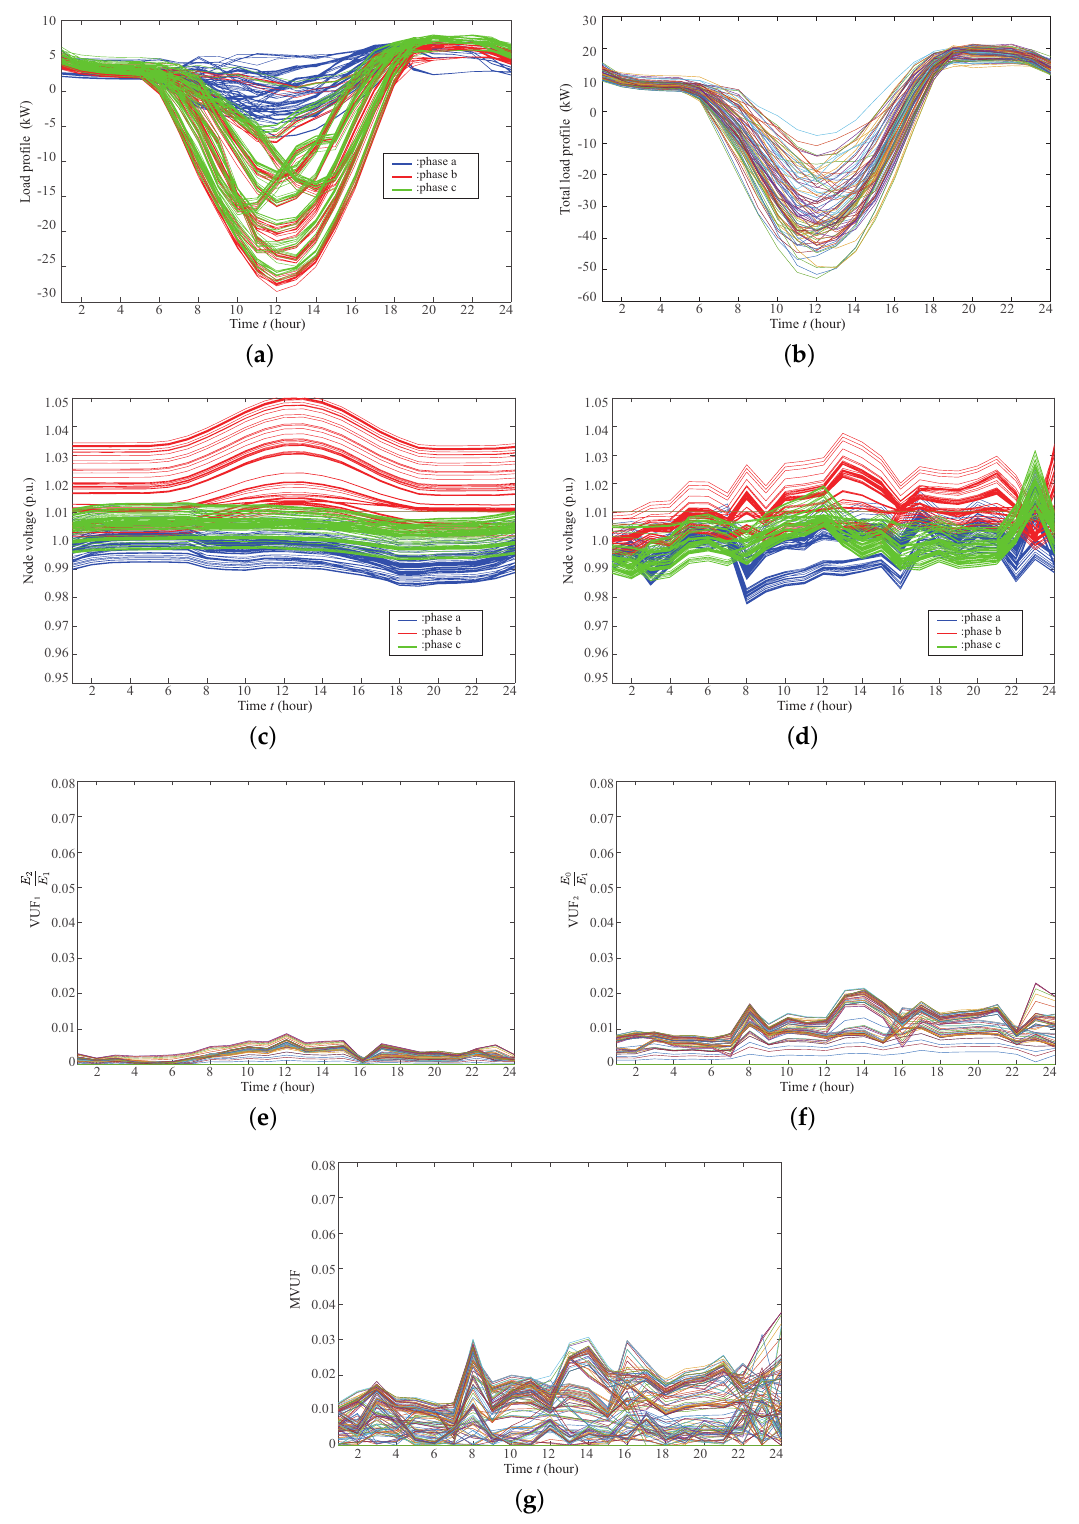
Figure 23. Simulation result of PQ control for unbalance compensation ( VUF 1 only): ( a ) load profile in each phase, ( b ) total load of node units, ( c ) voltage profile at before control, ( d ) voltage profile after compensation, ( e ) VUF 1 values, ( f ) VUF 2 values, and ( g ) MUVF